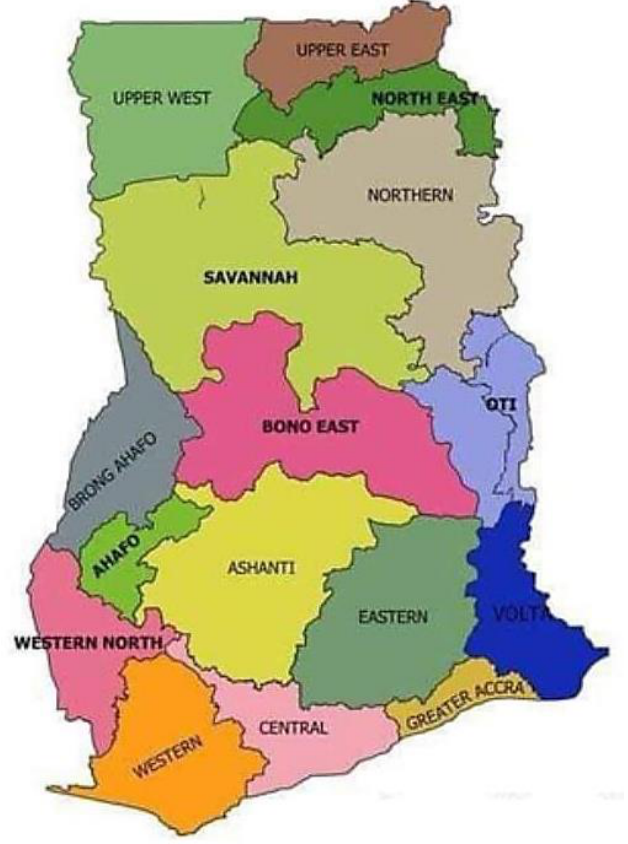
Figure 2. Map of Ghana showing Greater Accra and Asante region, the Zipline drone company